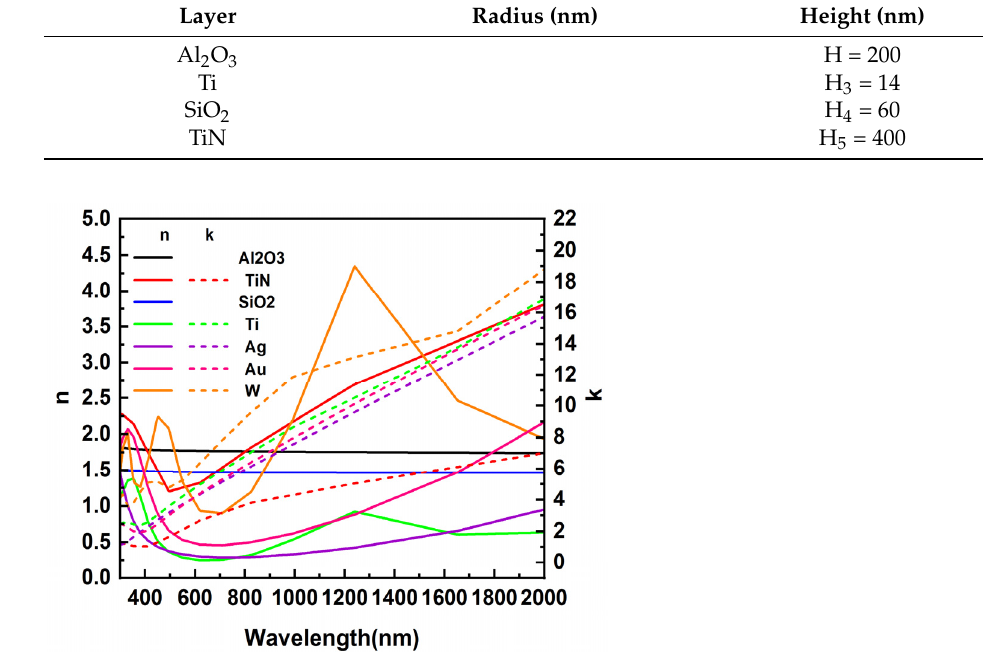
Figure 2. The refractive index and extinction coefficient of materials used in the simulation.